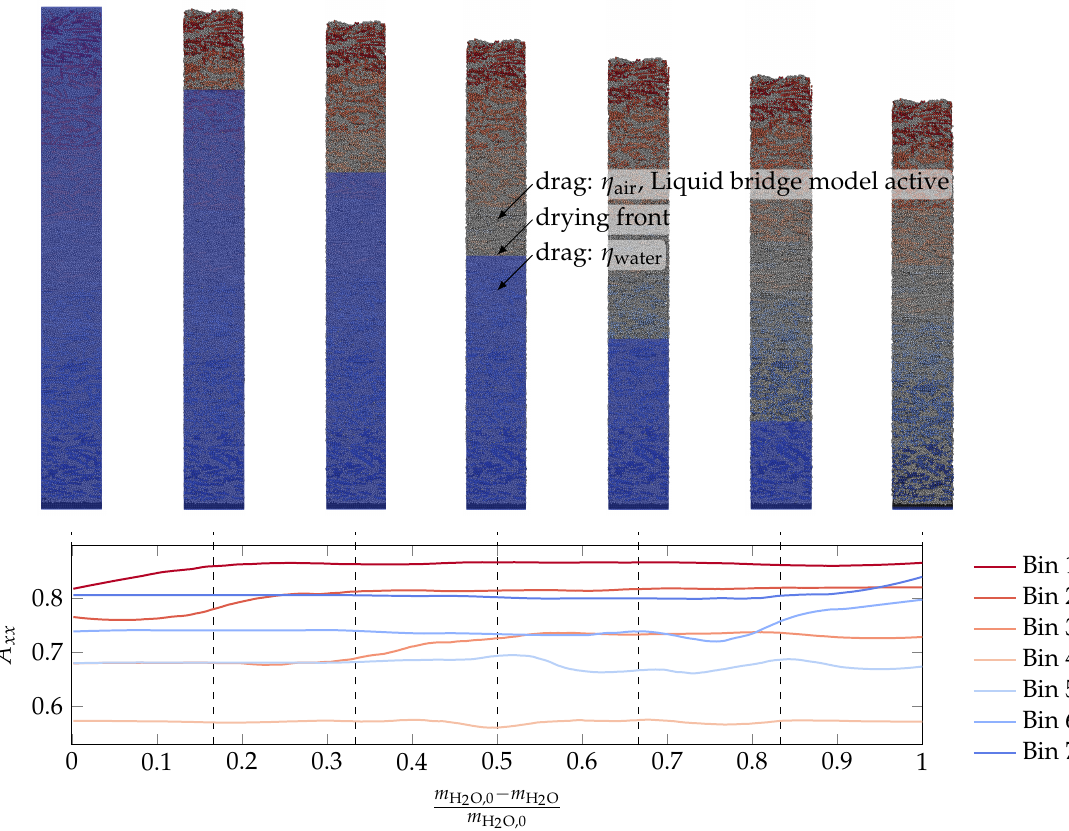
Figure 7. Exemplary drying simulation. The top sequence shows simulation screenshots in which the blue rectangle indicates the suspended area, while all particles above the blue rectangle are in air, but contain the remaining liquid, exerting capillary forces. The bottom graph shows the progress of the A xx orientation tensor element for the 7 bins that were classified in Figure